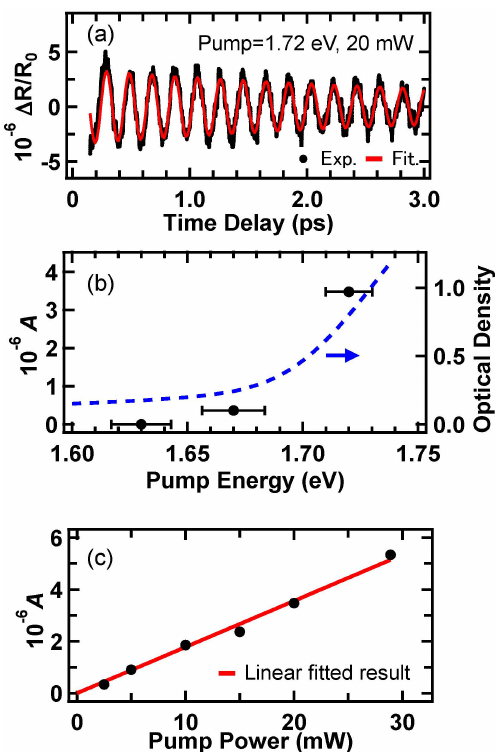
Figure 6. ( a ) Fitted result of the oscillatory signal of Figure 5b at 1.72 eV with 20 mW using a damped harmonic oscillation curve. ( b ) Pump photon energy dependence of the oscillation amplitude, where the bar indicates FWHM of the spectrum of pump pulses. The dashed curve indicates the absorption spectrum at 10 K. ( c ) Pump power dependence of the oscillation amplitude. The solid line is the linear fitted